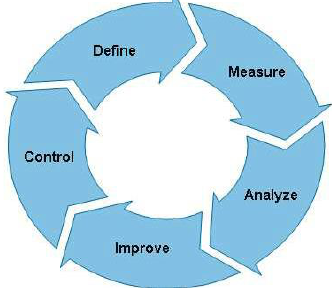
Figure 1: The DMAIC Structure and the Objectives (Source: Costello & Molloy,